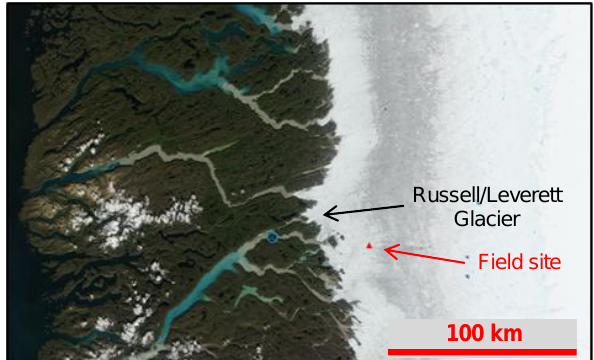
Figure 3. Field site location (red triangle) at ∼ 67 ◦ N in west Green- land, with the band of dark ice oriented north-south clearly visible in the ablation zone. The blue circle west of the field site marks Kangerlussuaq. The background image is a MODIS image acquired on 17 July